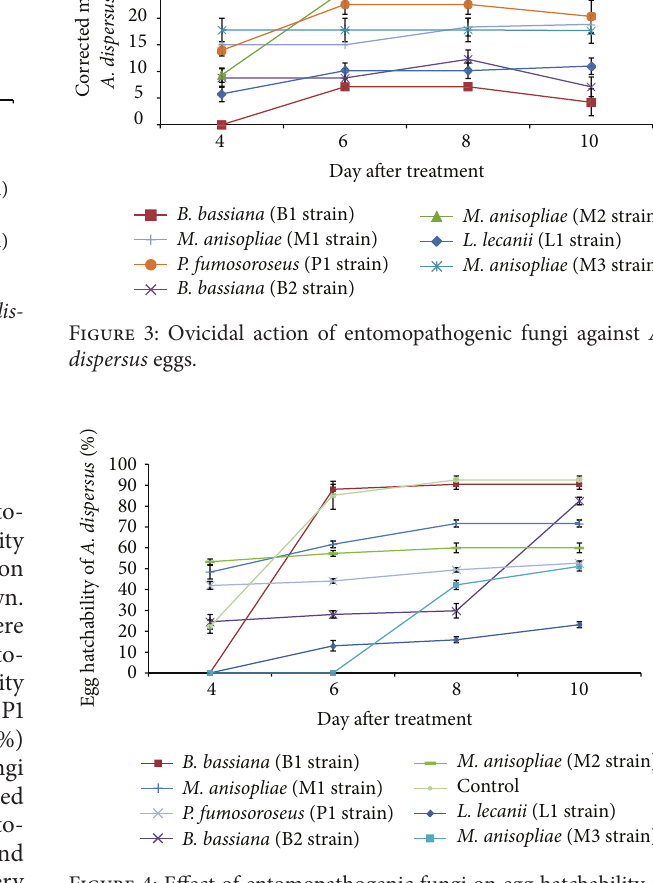
Figure 4: Effect of entomopathogenic fungi on egg hatchability of A. disperses